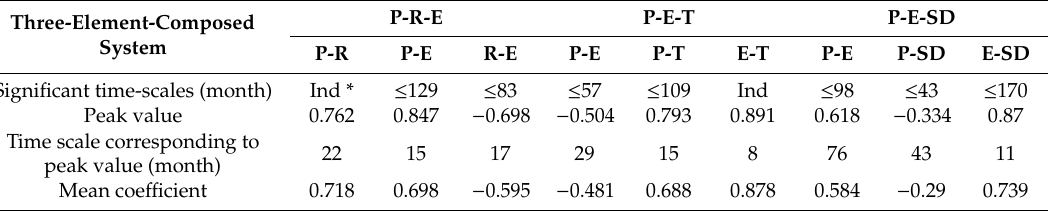
Table 2. Test result of significant correlation